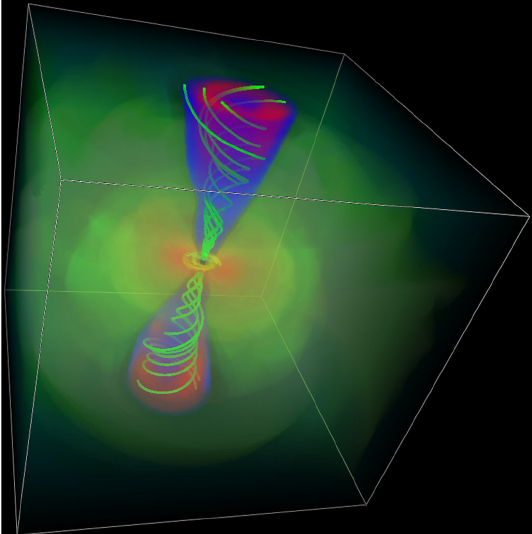
Figure 1. Inner ± 100 M BH cubical region at t = 4000 M BH of a 3D global GRMHD simulation of the formation of a jet starting with an equilibrium magnetized matter torus, whose angular momentum is aligned with the BH spin. The figure shows the BH, accretion disc (pressure, yellow isosurface), outer disc and wind (log rest-mass density, low green, high orange, and volume rendering), relativistic jet (Lorentz factor Γ ≤ 4, low blue, high red, volume rendering) and magnetic field lines (green) threading BH. (Figure 1 of